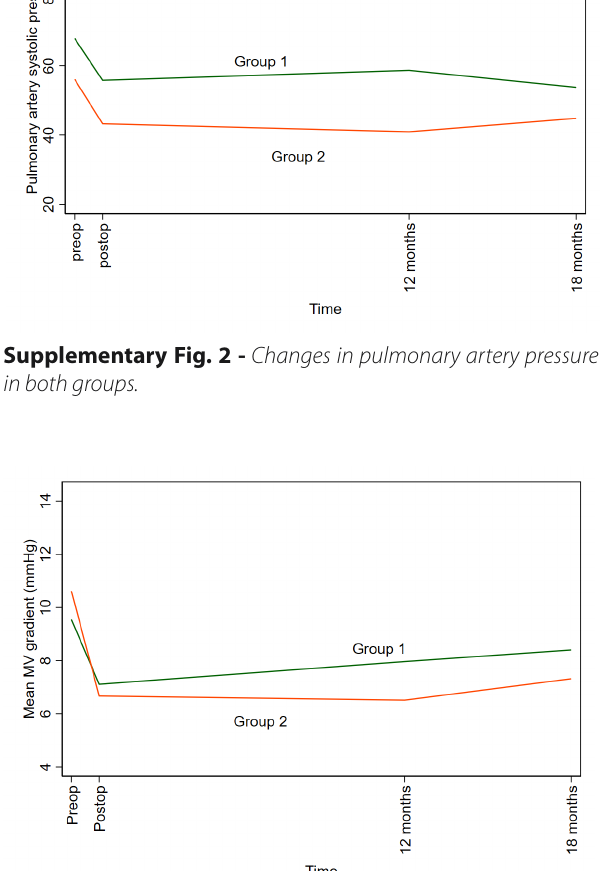
Supplementary Fig. 3 - Changes in mean mitral valve gradient in both groups.